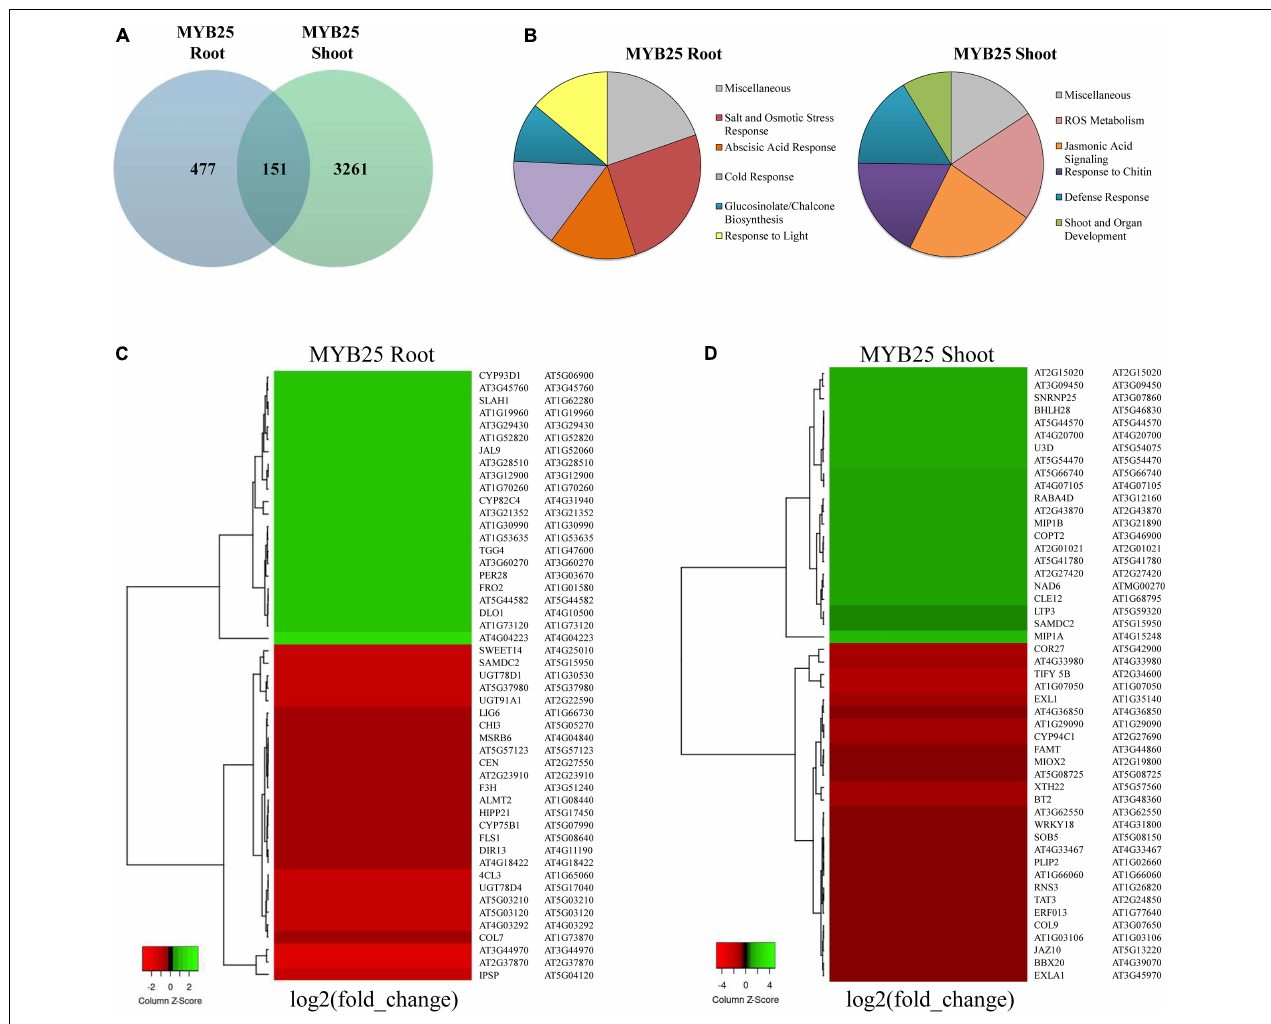
FIGURE 8 | Transcriptomic profiling in roots and shoots of MYB25:GFP overexpressing seedlings. (A) Venn diagram showing general gene expression changes compared to Col-0 wild type. (B) Pie diagrams showing the most prominent changes in cellular pathways based on GO term analysis (all depicted changes represent p < 0.01, q < 0.05 for MYB25 root and shoot). (C,D) Heatmap of the most differentially expressed genes in root and shoot of MYB25:GFP overexpressing seedlings generated with the online tool Heatmapper ( p < 0.01, q < 0.05;